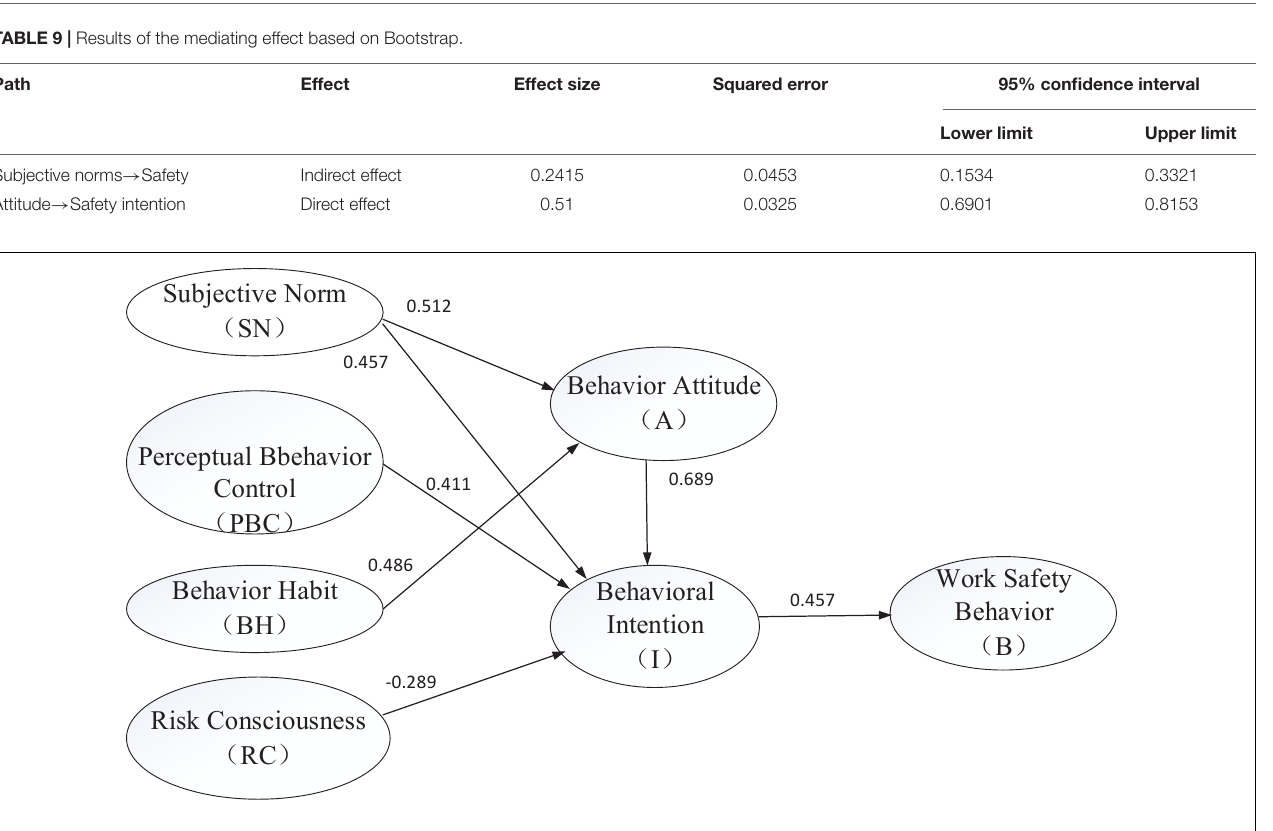
of behavior attitude, and the influence coefficient is